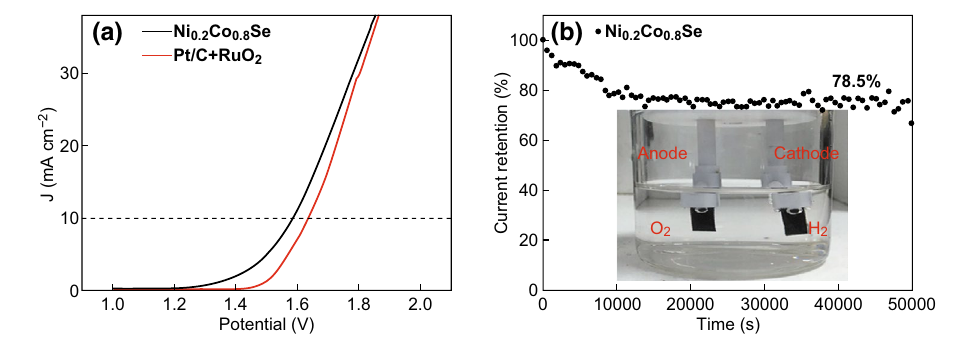
Fig. 7 a Water‑splitting polarization curves of Ni 0.2 Co 0.8 Se and Pt/C + RuO 2 in 1 M KOH. b Chronoamperometric response of Ni 0.2 Co 0.8 Se nanocages for overall water splitting. The inset shows the gas evolution on the two electrodes at 10 mA cm